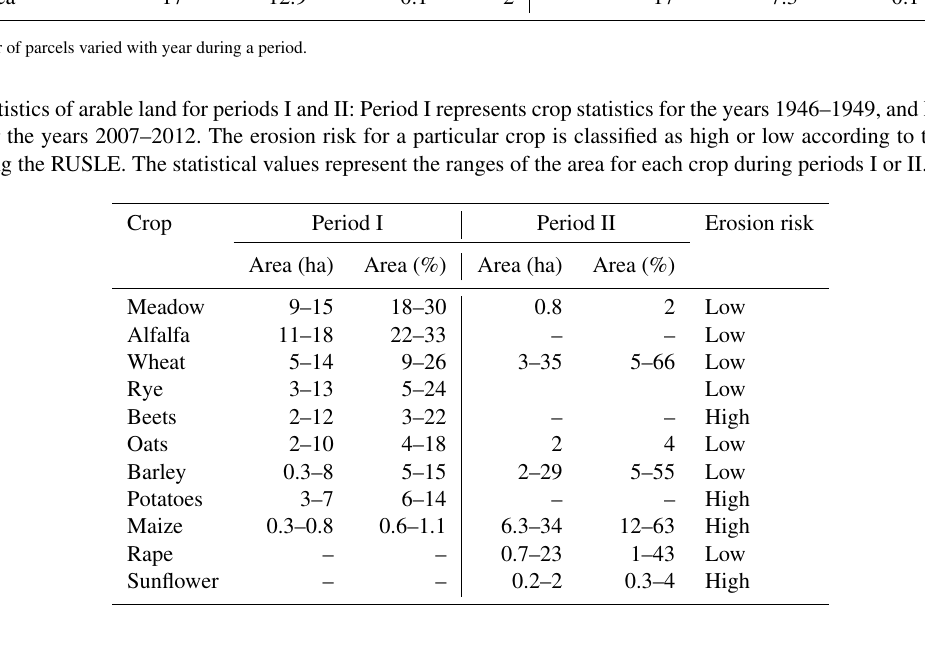
Table 3. Parameter values for the coefficients of the SRCs for dif- ferent periods and seasons according to Eq.